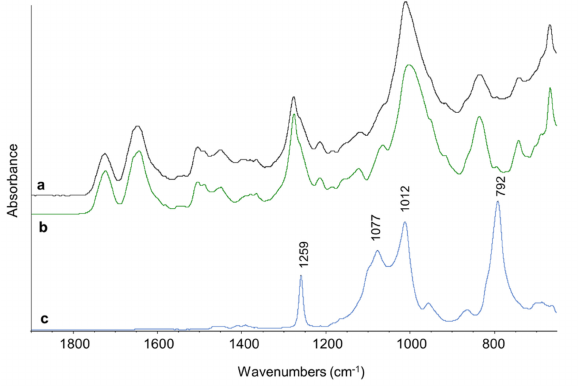
Figure 8. FTIR spectrum of the unprotected (np) area of mock-up C treated with propylene carbonate, compared with spectra of reference sprays. (a) C_I_np; (b) reference green alkyd spray; (c) reference red alkyd spray.